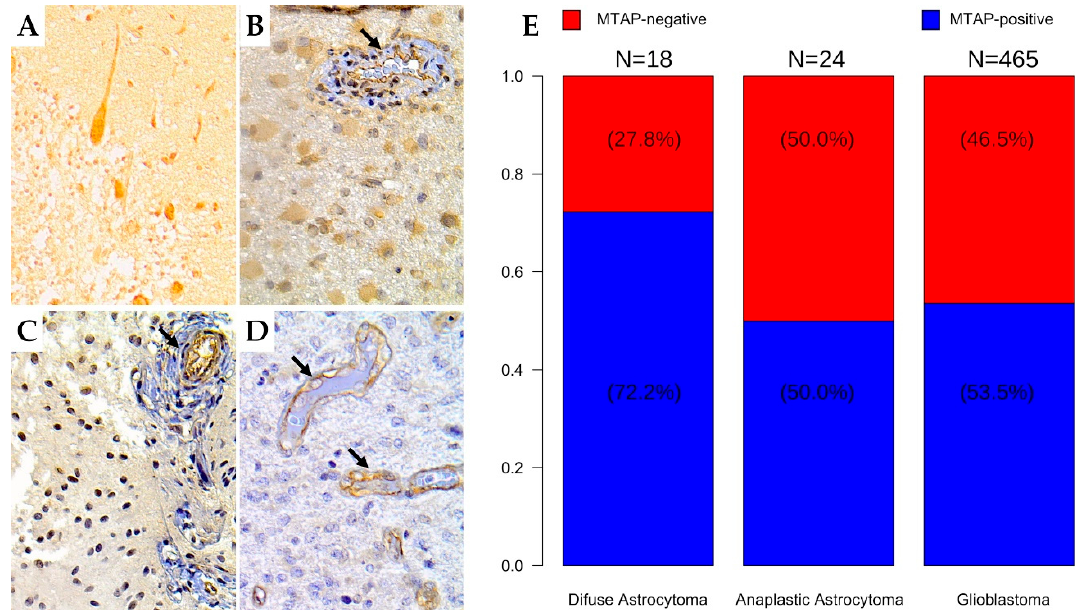
Figure 3. Immunohistochemistry staining for MTAP in human brain tumor tissues. The human brain tissue slide used for this study contained 507 cases of patients with different grades of gliomas in duplicates. Representative images from ( A ) normal cerebellum tissue (positive control); (400x) ( B ) diffuse astrocytoma (grade II); (400x) ( C ) anaplastic astrocytoma (grade III); 400x ( D ) glioblastoma (grade IV); 400x. Arrows indicate vessels with endothelial staining for MTAP protein (positive internal control). ( E ) Frequency of loss of MTAP protein expression in the glioma dataset according to histologic subtype.